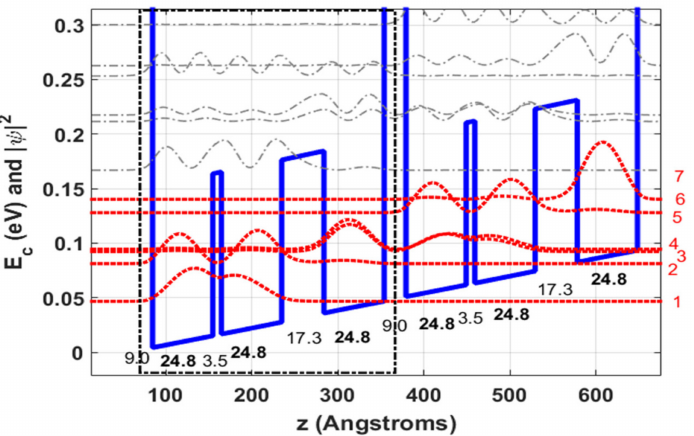
Figure 1. Band diagram of the SW–DP THz QCLs with mixed barriers: an Al 0.55 Ga 0.45 As injection barrier (nominally a pure AlAs barrier) and Al 0.15 Ga 0.85 As radiative and intrawell barriers. In the figure, two sequential regions define module i (left, marked by dashed-dotted box) and module i + 1 (right), corresponding to the energy levels of Device 1 (VB0837) with a doping level of ~3 × 10 10 cm − 2 (1 × doping) and Device 2 (VB0872) with double the doping (i.e., ~6 × 10 10 cm − 2 ) (2 × doping). Details of design and device parameters can be found in Tables 1 and 2